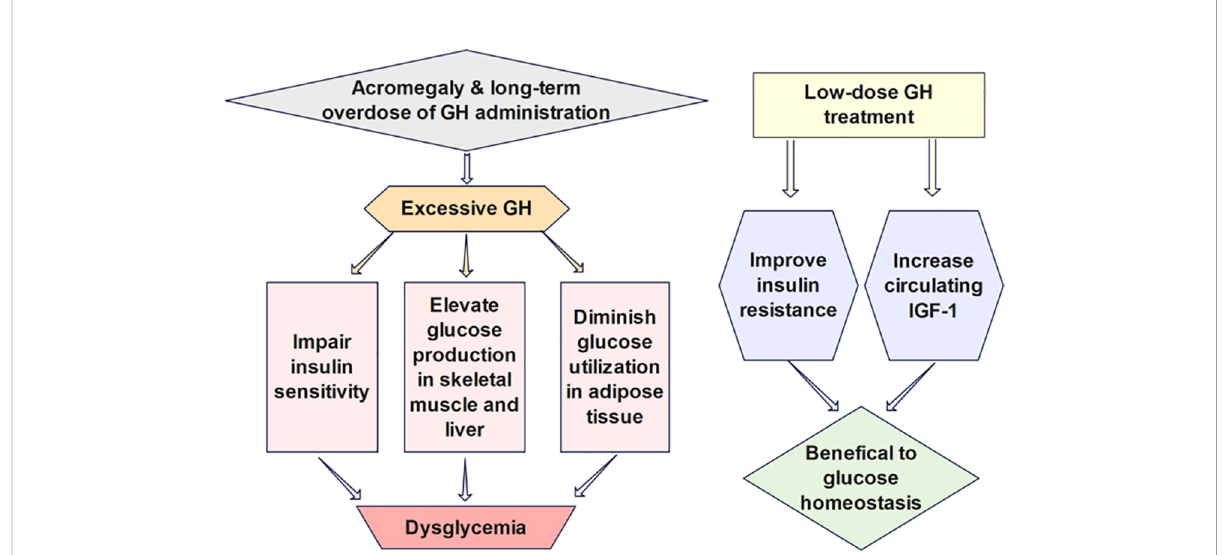
FIGURE 3 The effects of GH on glucose regulation are intricate partially due to its indirect impacts via IGF-1, which has glucose-lowering functions analogous to insulin. Low-dose GH has been shown to bene fi t insulin sensitivity and glucose homeostasis due to increased circulating IGF-1, while long-term GH treatment in high doses impairs insulin sensitivity and exacerbates insulin